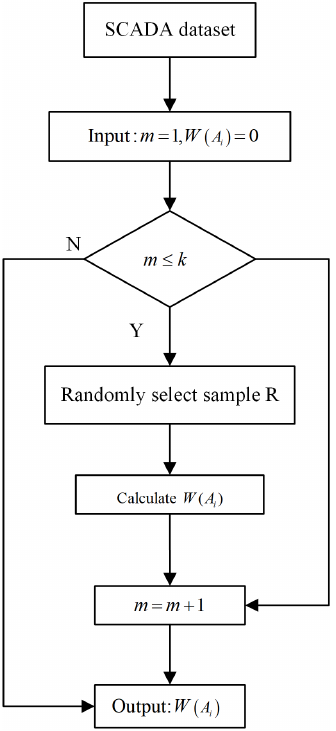
Figure 2. The flowchart of the feature simplification